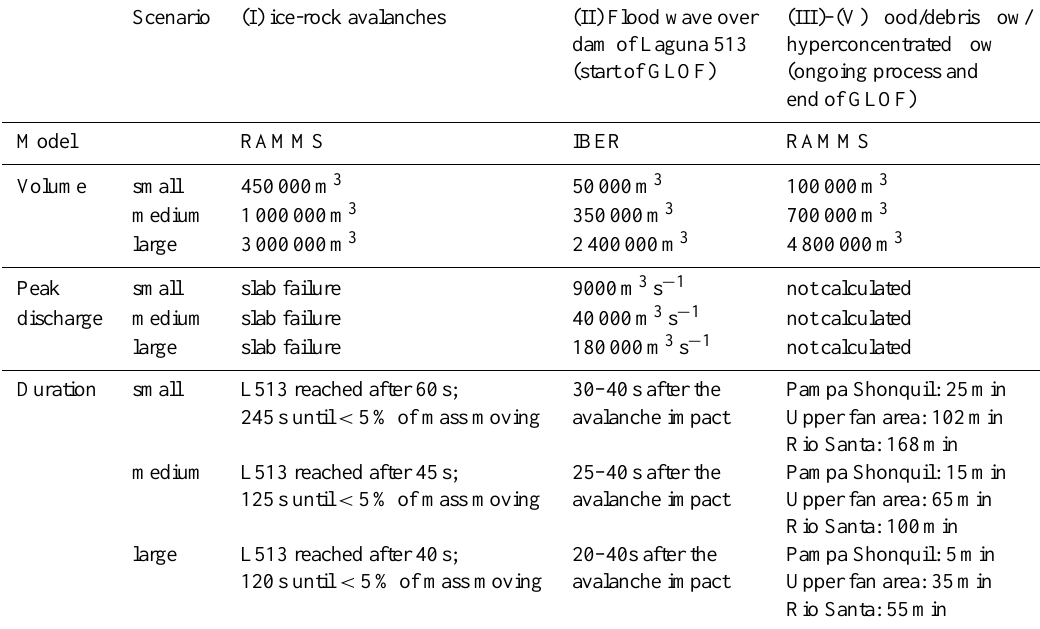
Table 1. Overview of volumes, peak discharges, and durations of the mass movement for each scenario and the applied models. Roman numbers correspond to the process stages described